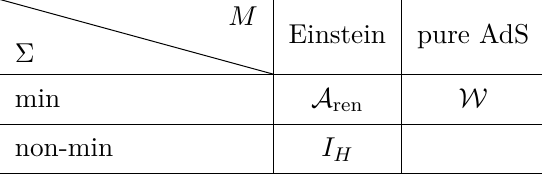
Table 1 . Energy functionals from L Σ